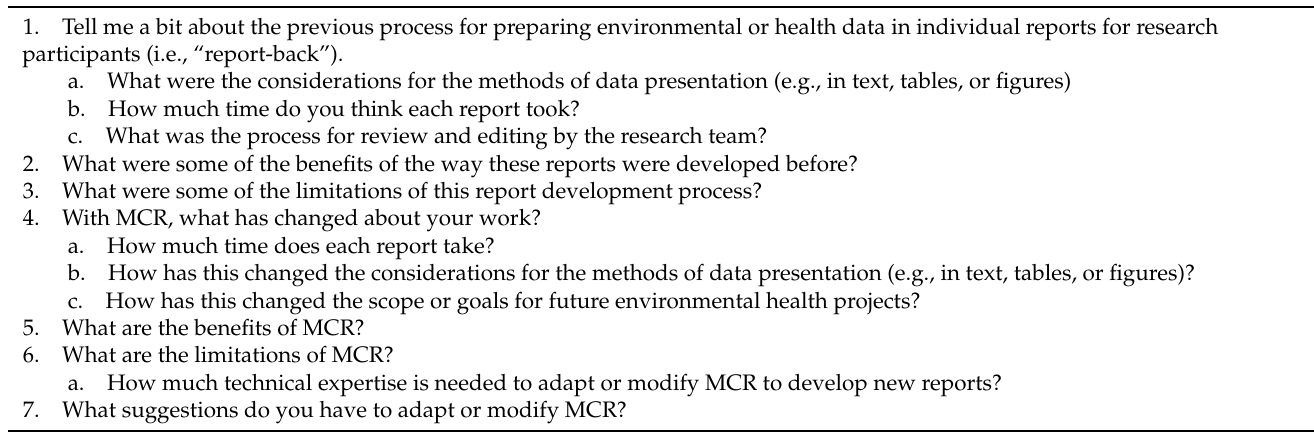
Table 1. Semi-structured interview questions for the research team members using MCR in a subsequent report-back.